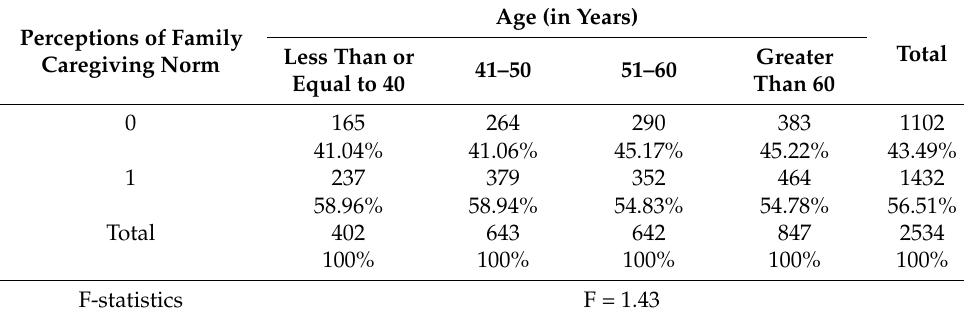
Table 3. Perceptions of family caregiving norms by age